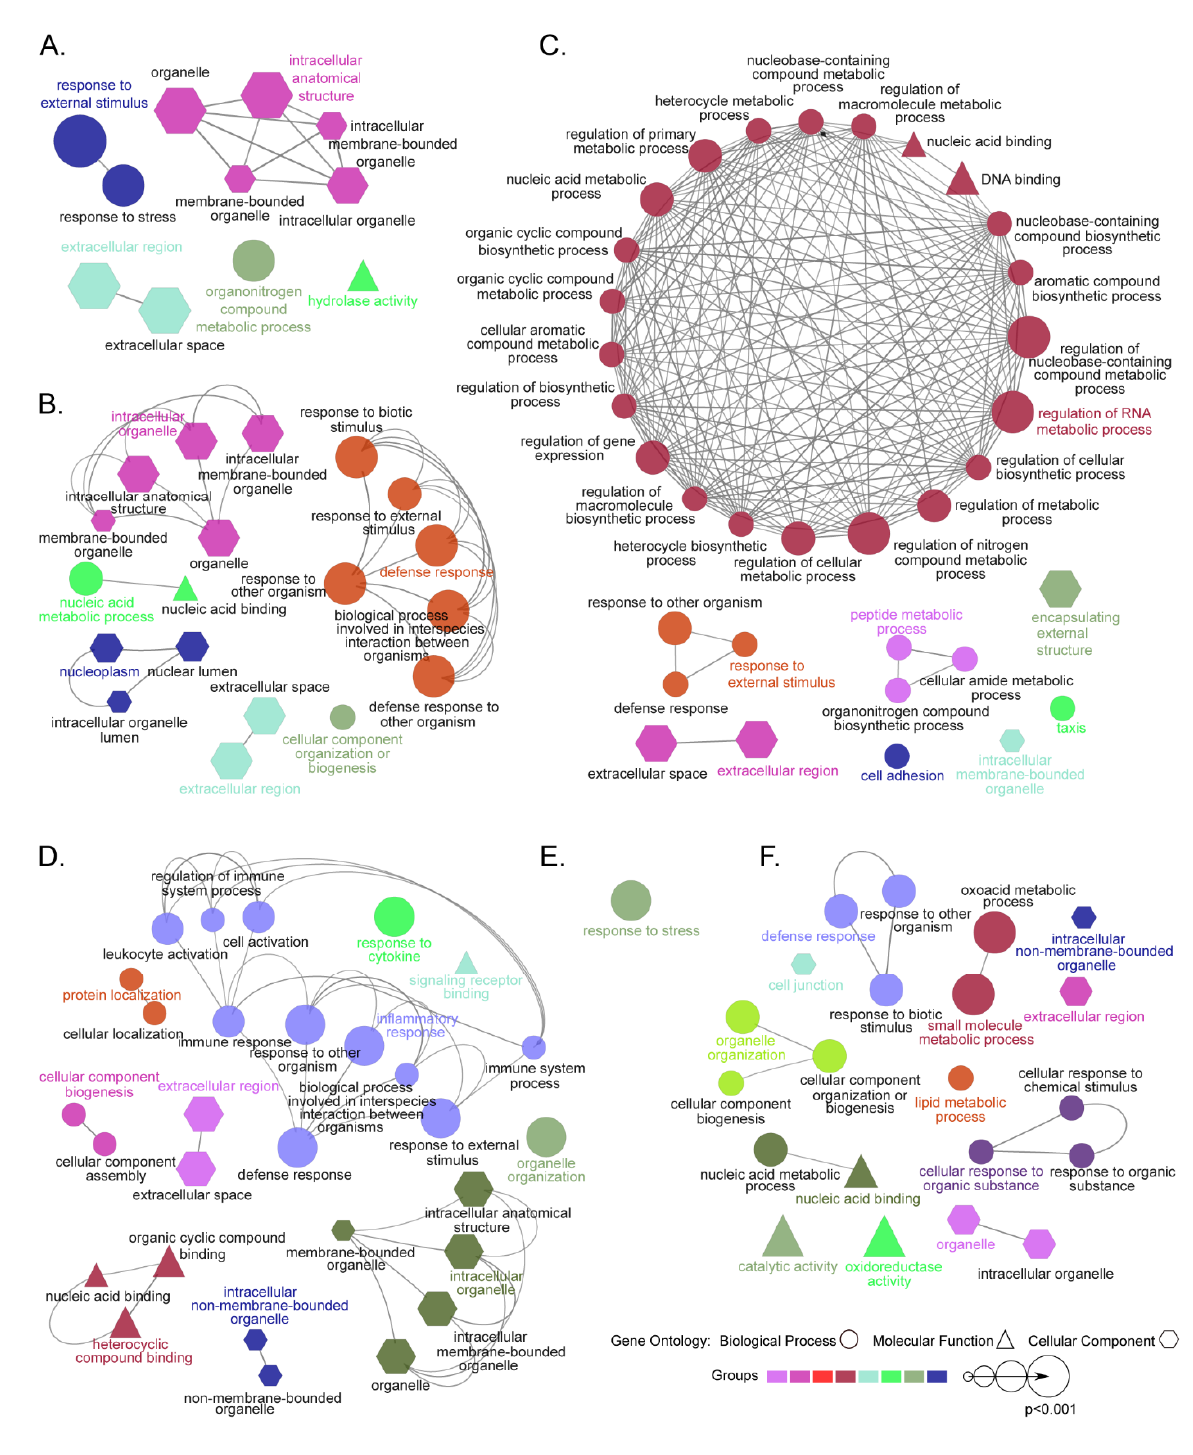
Figure 6. ClueGO-based enriched gene ontology (GO) terms in lumpfish lymphoid organs. ( A ) . GO terms identified from DEGs in the head-kidney at 3 dpi; ( B ) . GO terms identified from top 600 DEGs in the head-kidney at 10 dpi; ( C ) . GO terms identified from DEGs in the spleen at 3 dpi; ( D ) . GO terms identified from top 600 DEGs in spleen at 10 dpi; ( E ) . GO terms identified from DEGs in liver at 3 dpi; ( F ) . GO terms identified from top 600 DEGs in liver at 10 dpi. The size shows the GO term significance (the bigger the size the higher the significance). The shapes depict the database source i.e., GO biological process (ellipse), GO cellular component (hexagonal), and GO molecular function (triangles). The statistics of representative GO terms or pathways are tabulated in file S6.